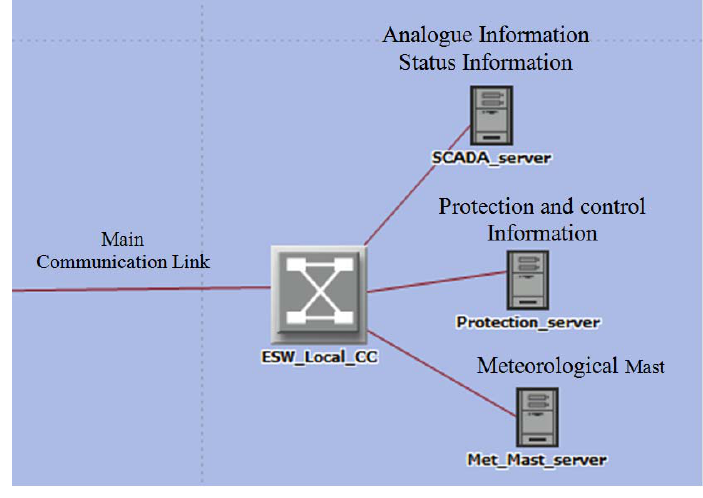
Figure 8. Control center configuration in OPNET.